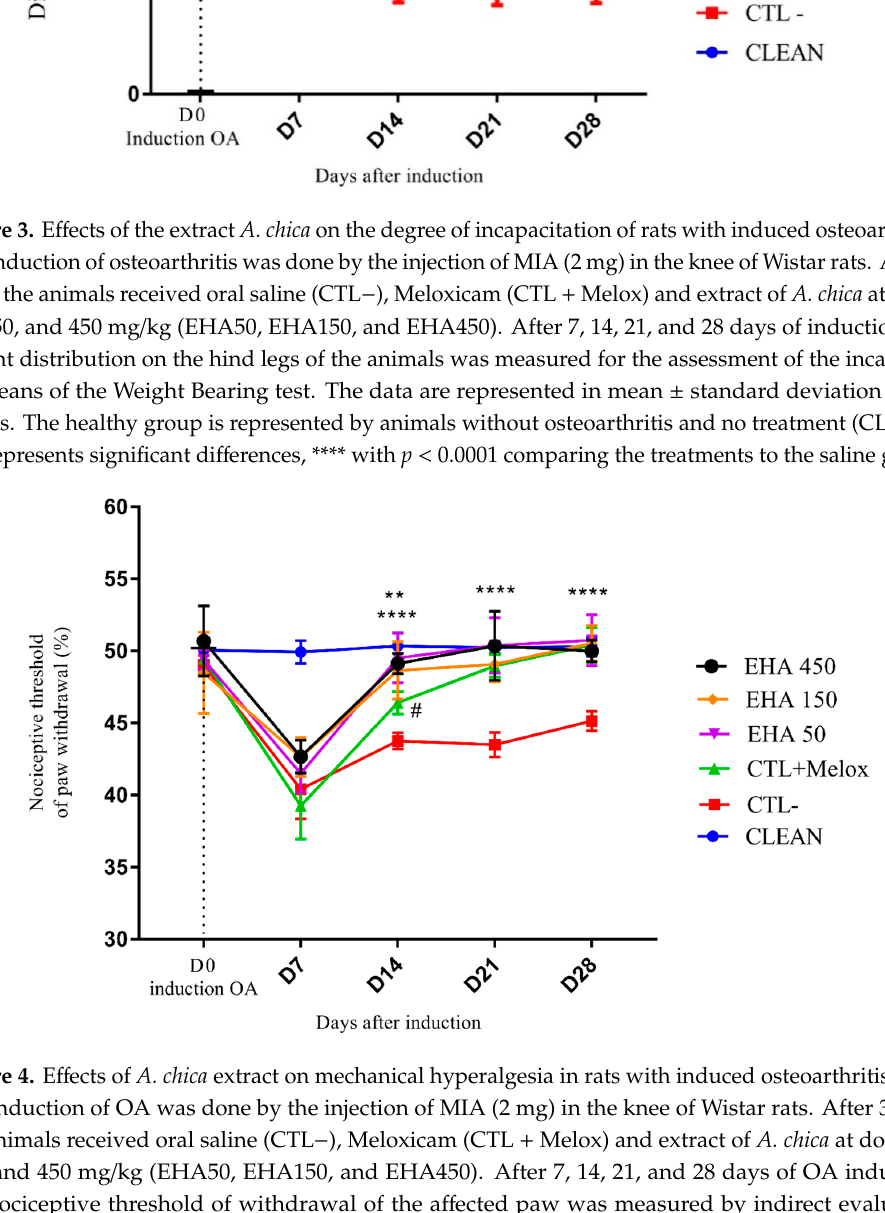
Figure 3. Effects of the extract A. chica on the degree of incapacitation of rats with induced osteoarthritis. The induction of osteoarthritis was done by the injection of MIA (2 mg) in the knee of Wistar rats. After 3 days, the animals received oral saline (CTL − ), Meloxicam (CTL + Melox) and extract of A. chica at doses 50, 150, and 450 mg/kg (EHA50, EHA150, and EHA450). After 7, 14, 21, and 28 days of induction, the weight distribution on the hind legs of the animals was measured for the assessment of the incapacity by means of the Weight Bearing test. The data are represented in mean ± standard deviation of the means. The healthy group is represented by animals without osteoarthritis and no treatment (CLEAN). **** represents significant differences, **** with p < 0.0001 comparing the treatments to the saline group.